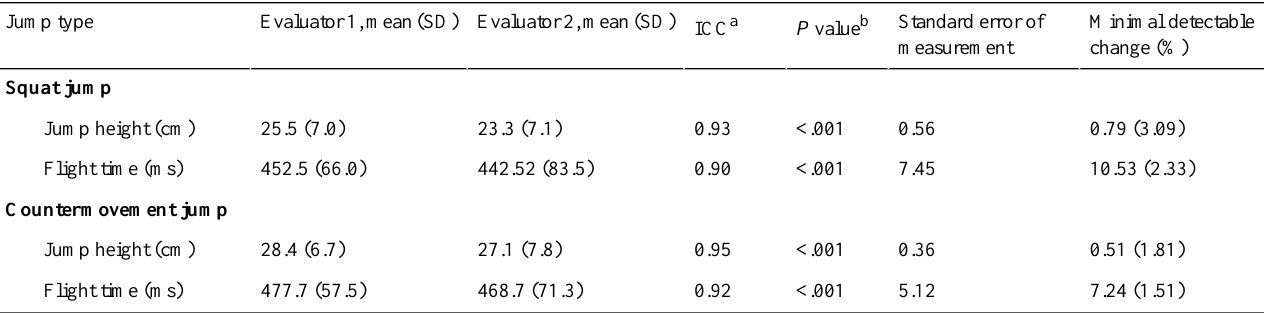
Table 2. Interevaluator intraclass correlation coefficient of squat jump and countermovement jump measurements in the MyJump2TM App.